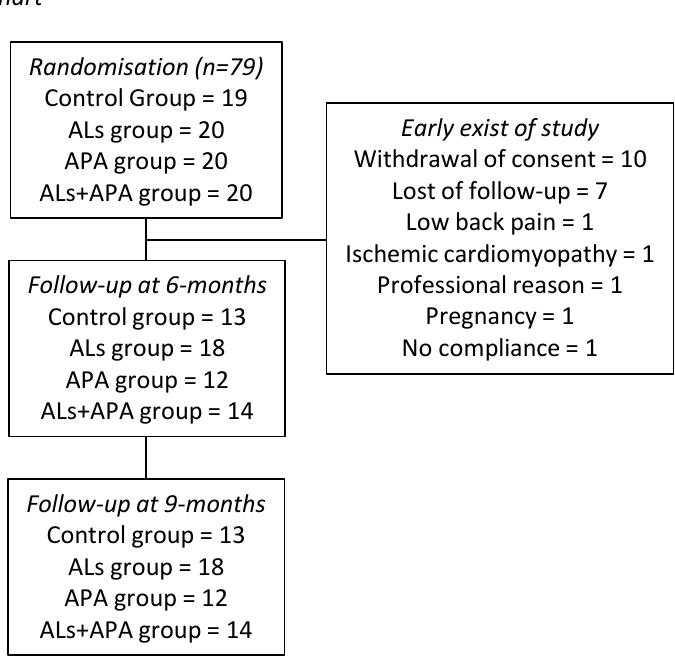
Figure 1. Flow chart. ALs, arginine and leucine supplementation; APA, adapted physical activity.